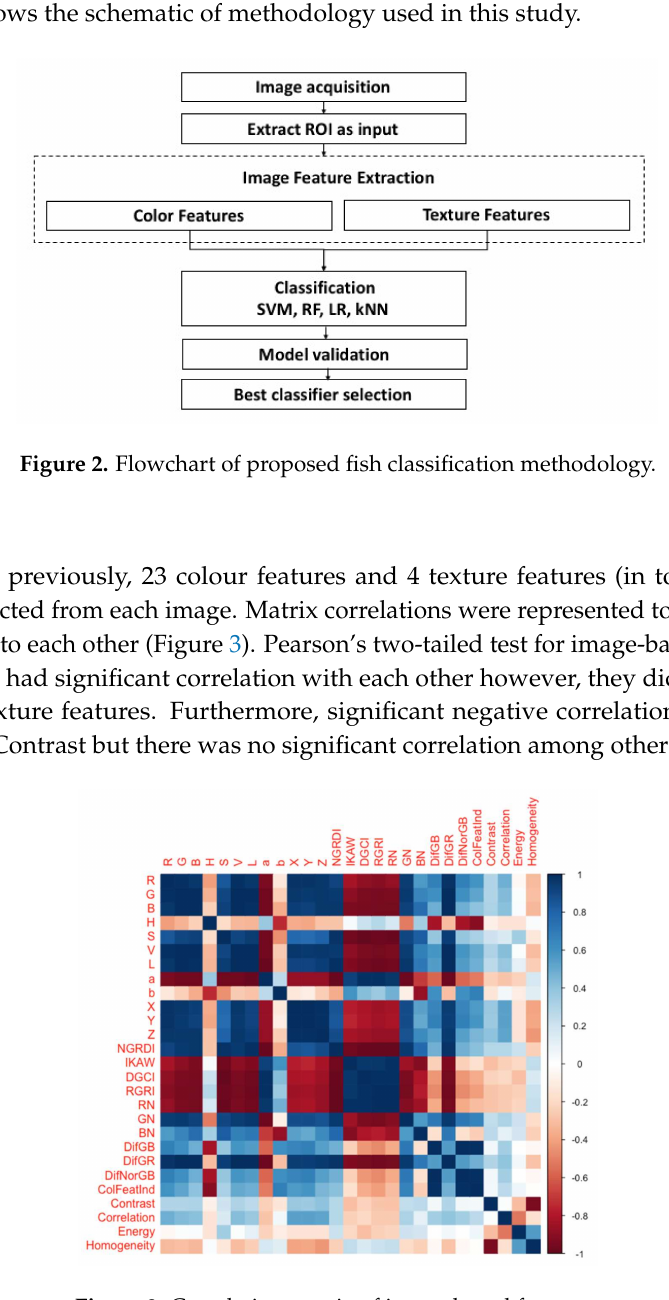
Figure 3. Correlation matrix of image-based